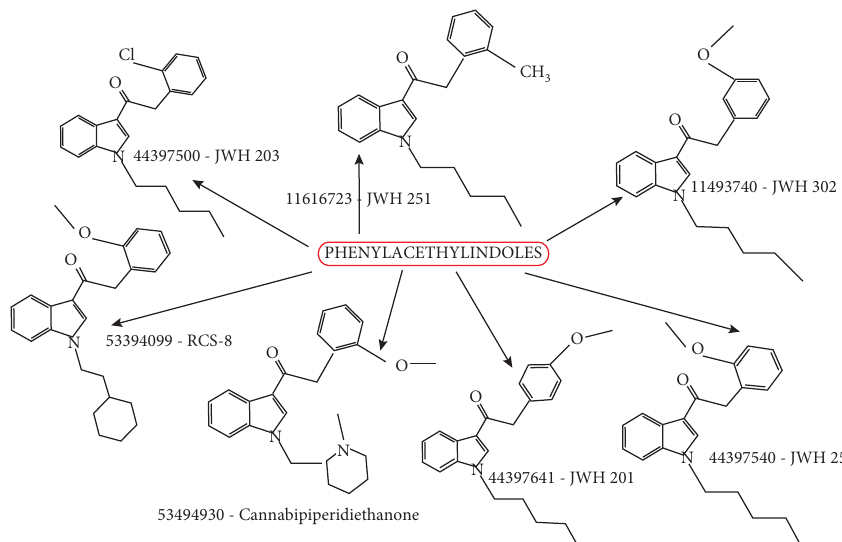
Figure 4: The structures of the molecules from the phenylacetylindoles